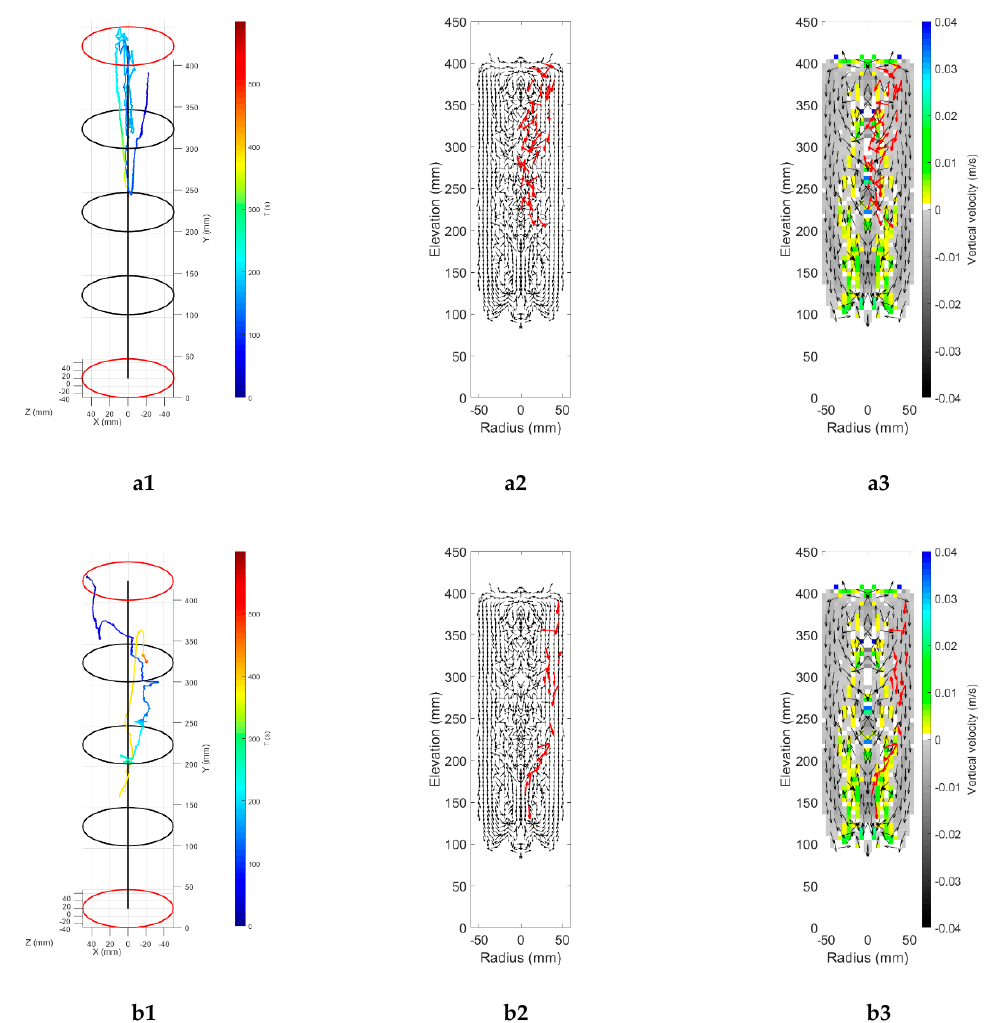
Figure 5. The results of 2 runs ( a , b ) of a − 212 + 150 µm hematite particle for an airflow rate of 1.25 u mf (Lagrangian trajectory (1) and Eulerian flow maps (2 and 3)). It was observed that, even though the tracer did not stay at the bottom, some hematite particles fed to the fluidized bed reached the bottom and remained there. However, even though there was a separation, the recovery of the heavy particles would be lower than coarse bed ( − 300 + 212 µm) separation. Regardless of the low recovery, it shows that there is still a potential for separation in this size fraction.